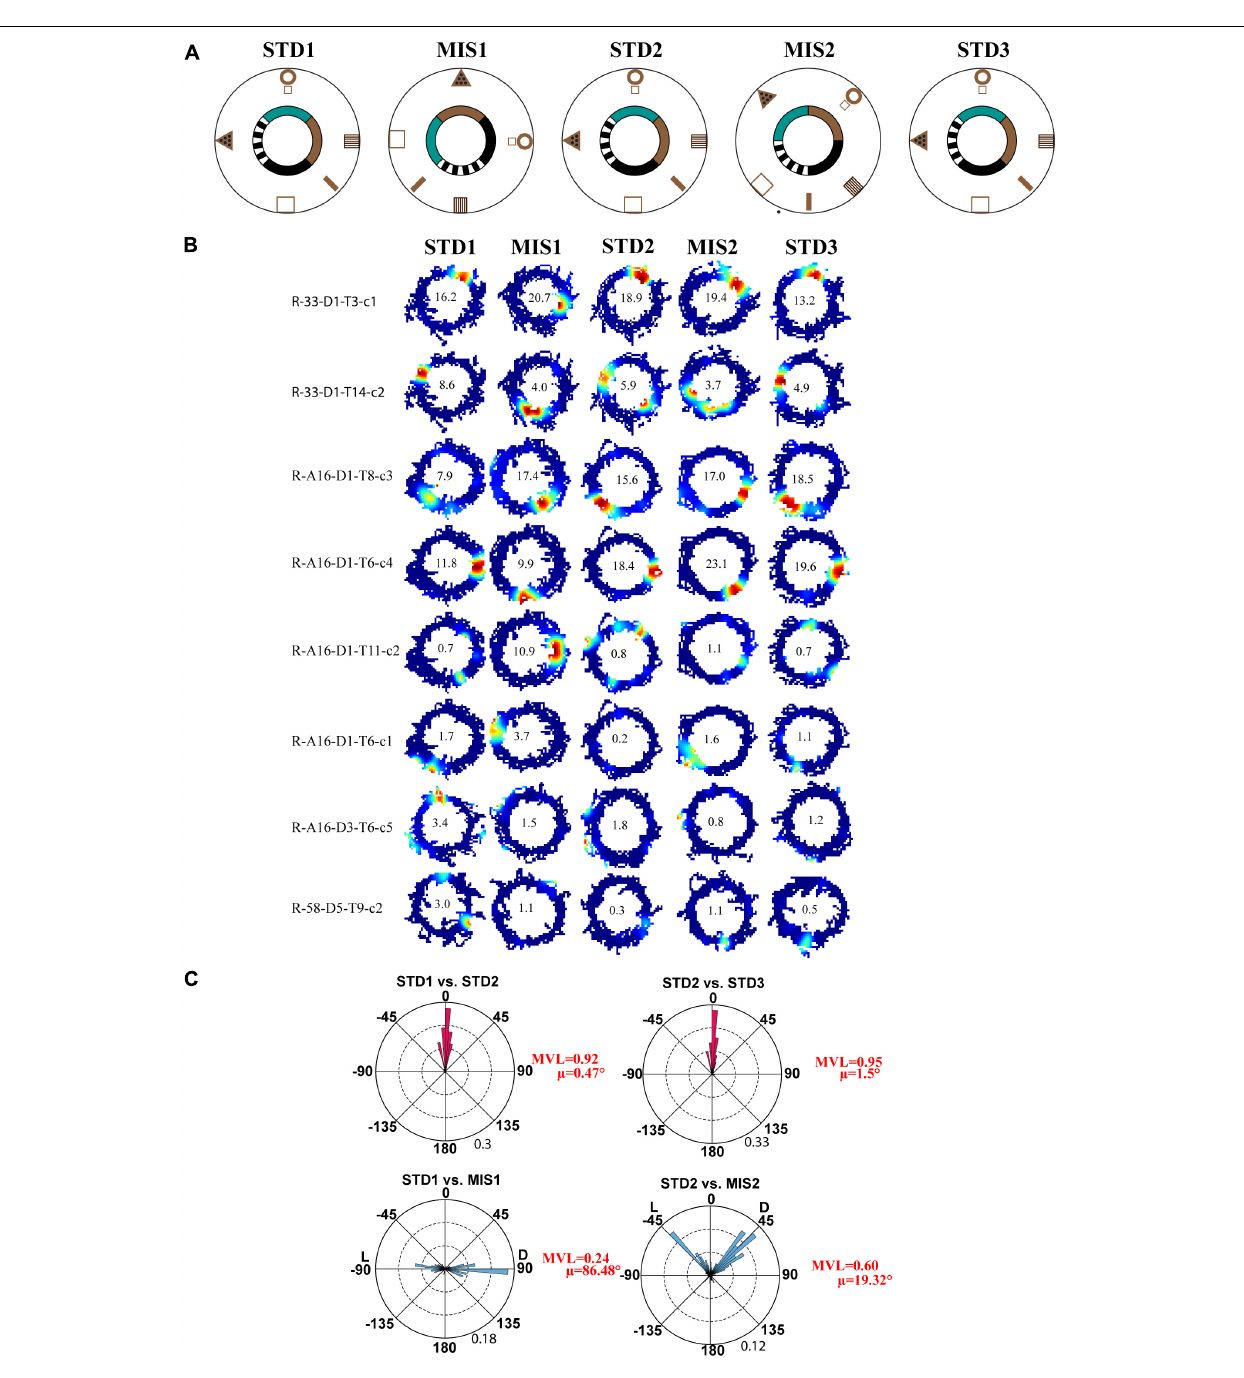
FIGURE 2 | Schematic representation of the double rotation experiments with a textured track as a local cue (Tex). (A) The schematic representation of the Tex double-rotation paradigm. In this paradigm, the reward was provided at random locations on the textured track. (B) Representative place fields from five sessions showing heterogeneous representation. The number inside the firing rate maps indicates the peak firing rate [in Hertz (Hz)]. The rate maps are color coded, with red color denoted by > 90% of the peak firing rate; no firing is indicated by blue, and successive gradients in the firing rates are shown with intervening colors in the spectrum. Clusters R-33-D1-T3-c1 and R-33-D1-T14-c2 are co-recorded neurons orienting to distal and local cues, respectively, demonstrating heterogeneous response from CA1. Clusters R-A16-D3-T6-c5 and R-58-D5-T9-c2 show the place field that did not fire in all sessions. Cluster R-A16-D1-T11-c2 shows remapping of place cells. (C) Circular histogram shows place field rotation across different standards and mismatch comparisons. L and D indicate the rotation of local and distal cues. The mean vector length (MVL) and mean direction ( µ ) of comparisons are shown alongside the plot. The numbers in brown indicate the maximum proportion of place fields (an outer